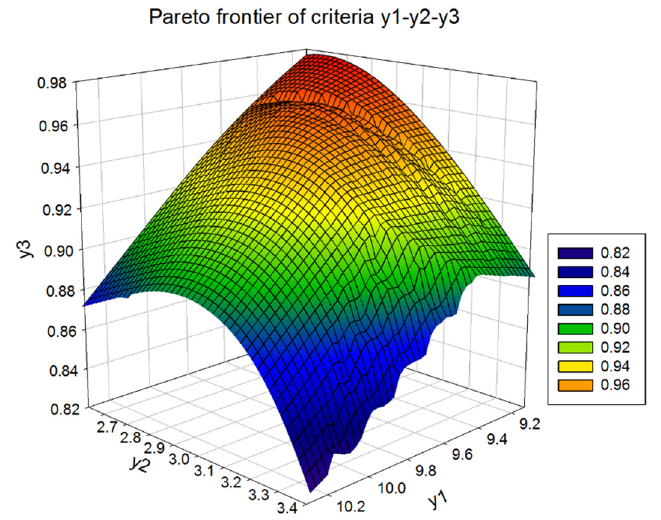
Figure 5. Contour plot of Pareto frontier of criteria y 1, y 2, y 3 .